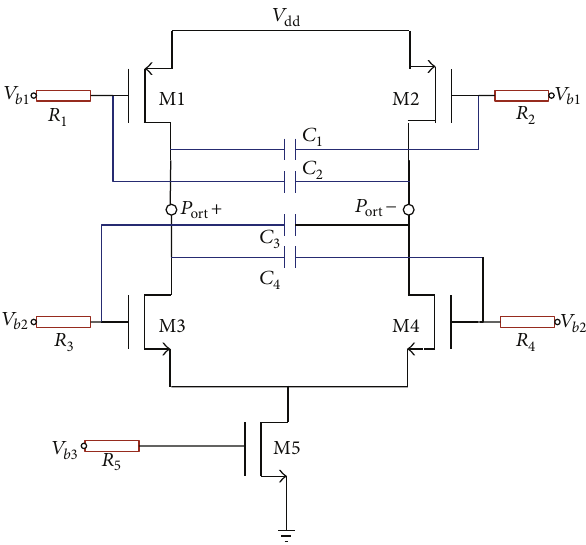
Figure 5: Negative resistance block using cross-coupling architec-